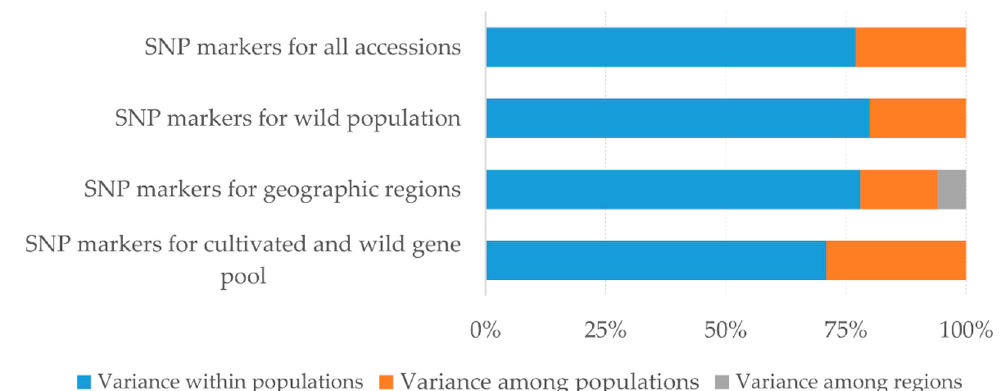
Figure 4. The Analysis of Molecular Variance (AMOVA) framework.